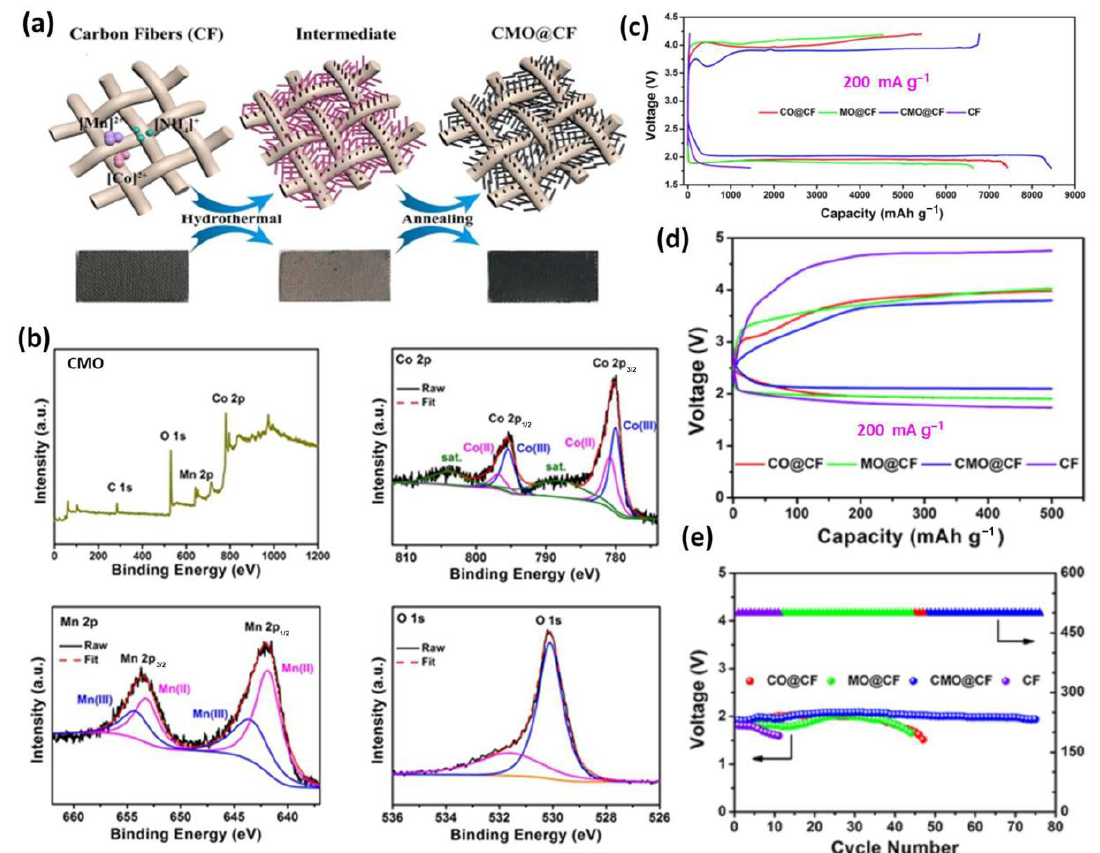
Figure 6. ( a ) Schematic illustration of preparation process of CMO@CF electrodes; ( b ) XPS spectra of CMO sample, Co 2p, Mn 2p, and O 1s; ( c ) Galvanostatic charge–discharge curves of the TMO@CF and CF cathodes with the cut-off voltage of 1.8–4.2 V; ( d ) Galvanostatic discharge–charge curves of the TMO@CF and CF electrodes at first cycles with a capacity limitation of 500 mAh –1 ; ( e ) The terminal discharge potential vs. the cycling number of the TMO@CF and CF at 500 mAh –1 . Reproduced with permission from [89]. Copyright 2018, American Chemical Society.